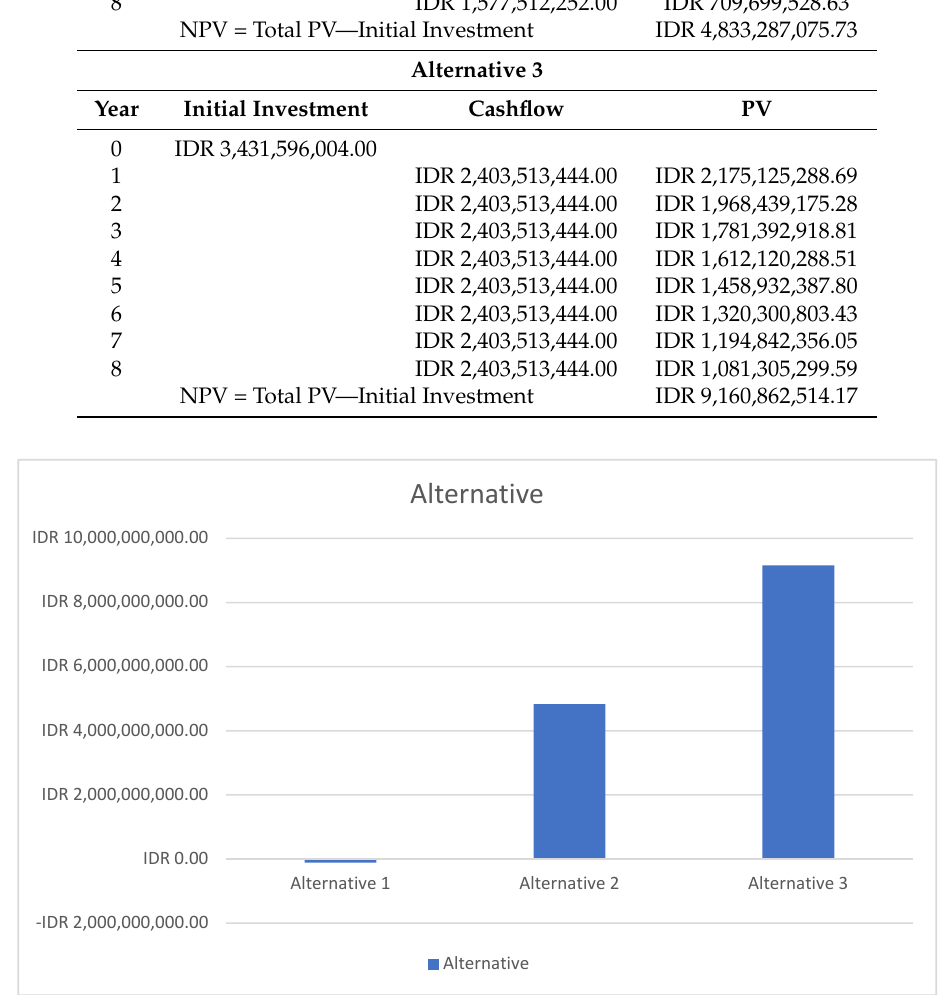
Figure 4. NPV Calculation Result.